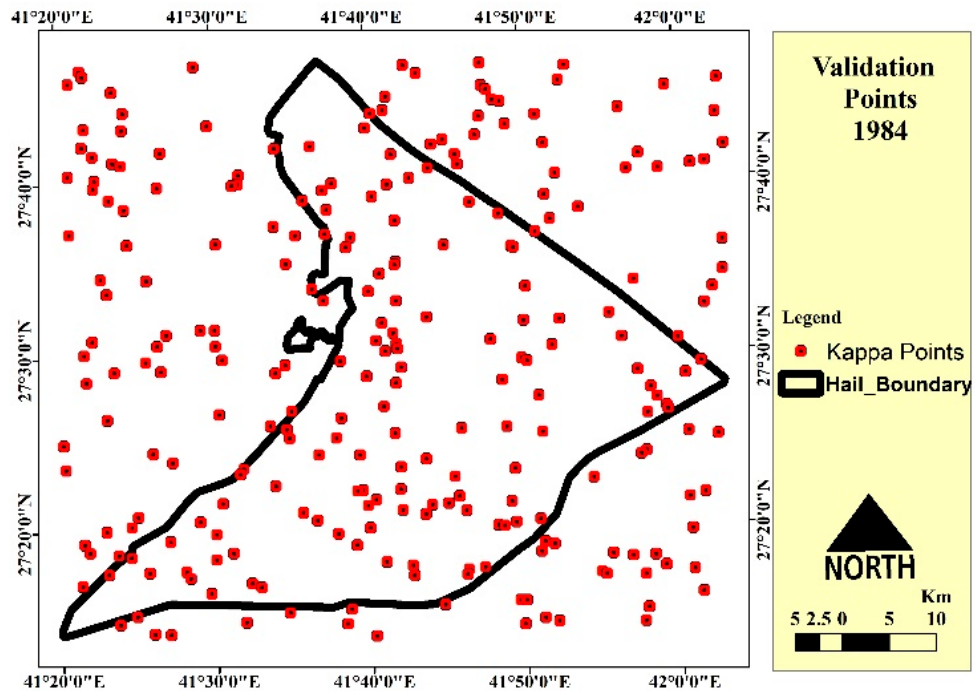
Figure 9. Distribution of Kappa validation points for 1984.